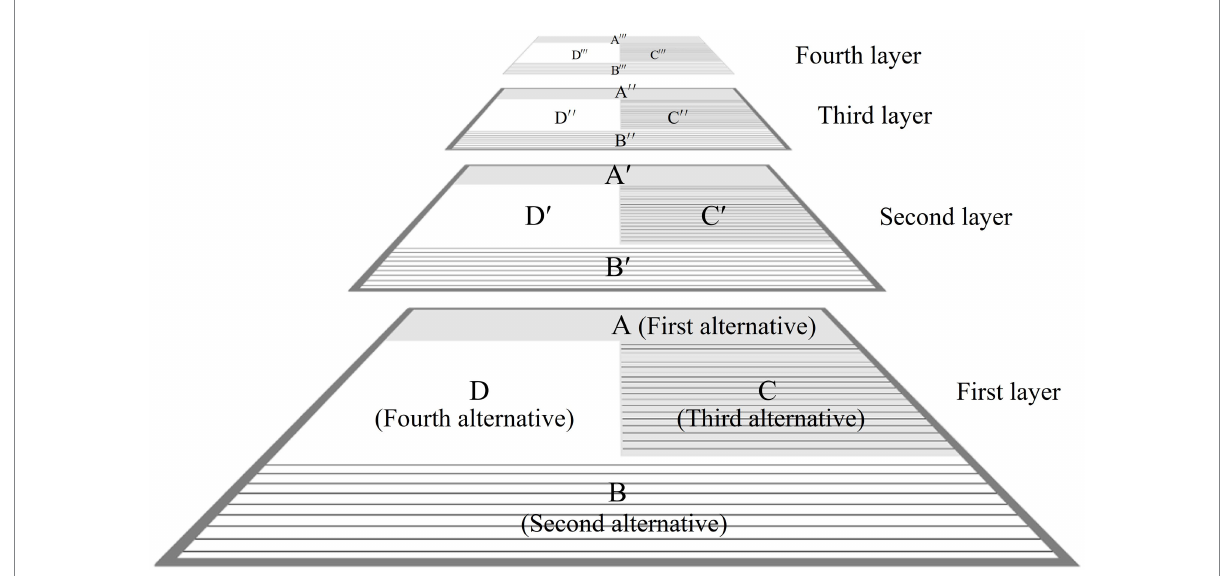
FIGURE 4 The three-dimensional structure of the Four-layered Catus ̣ kot ̣ i